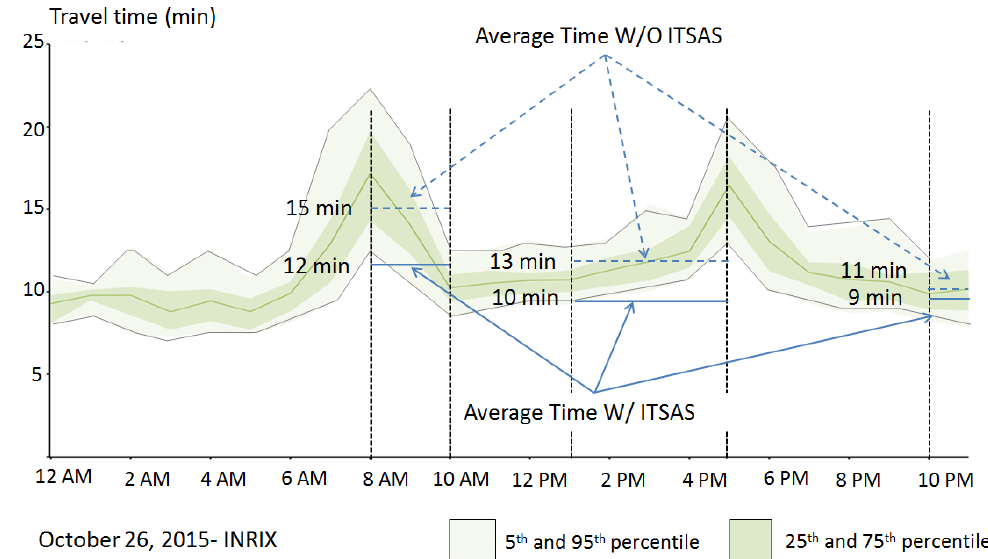
Figure 8. Corridor congestion and travel time w/ and w/o ITSAS.